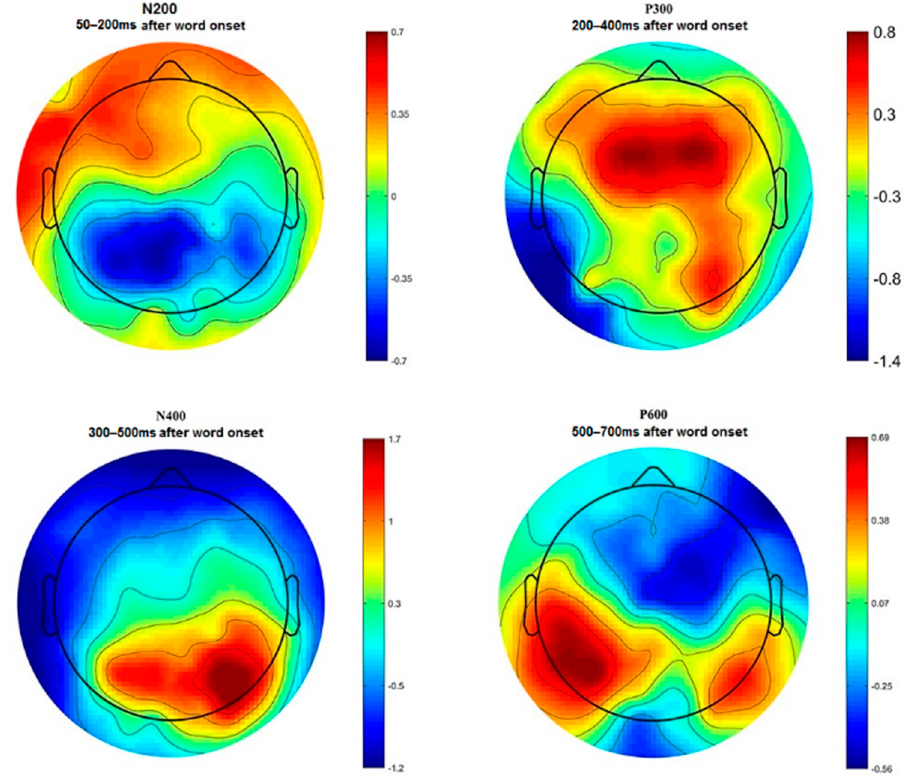
Figure 4. Topographical distribution of ERP amplitude averaged across all participants for N200, P300, N400, and P600 peaks.